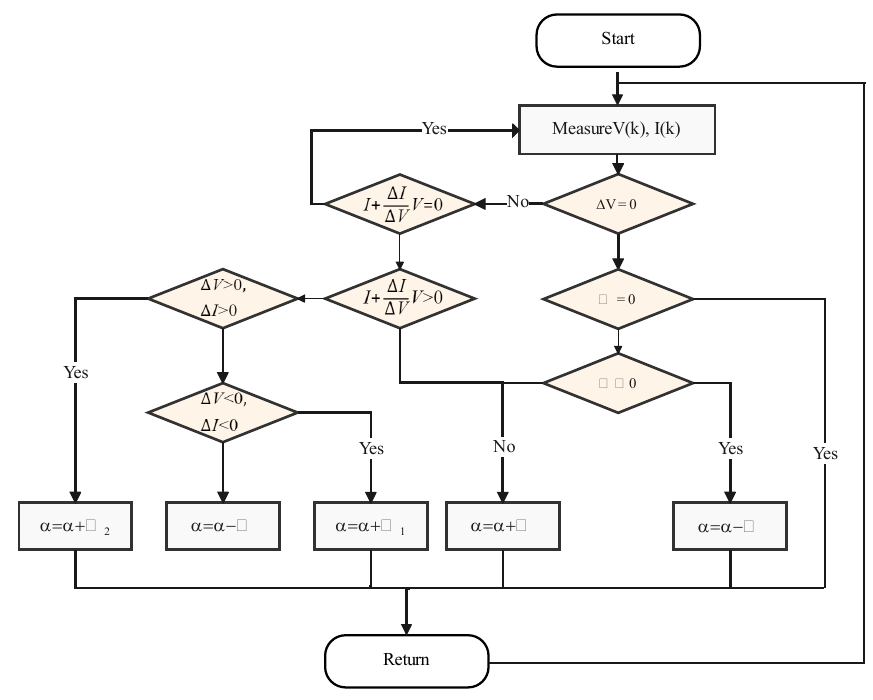
Figure 7. Flowchart of the M-INC algorithm.